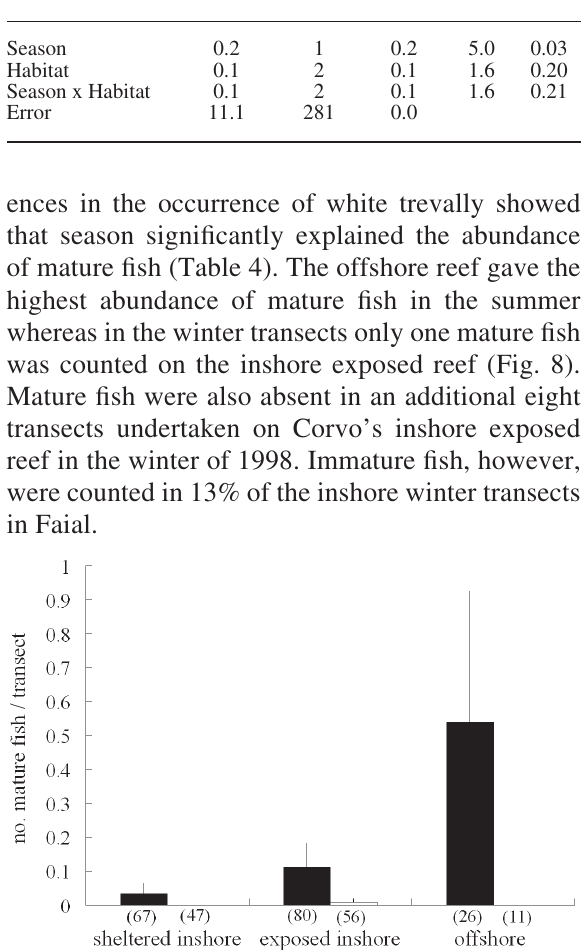
Fig . 8. – Abundance in transects (x ± se ) of mature white trevally ) at faial island according to reef habitat type dur- (fish >30 cm L T ing the summer spawning season (black bars) and the non-spawning season (white bars). sample sizes are given in